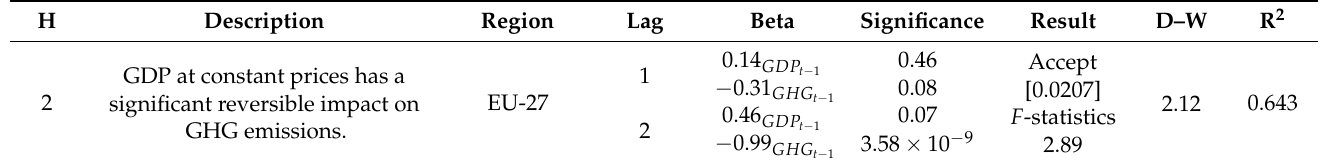
Table 5. Testing Hypothesis 2.